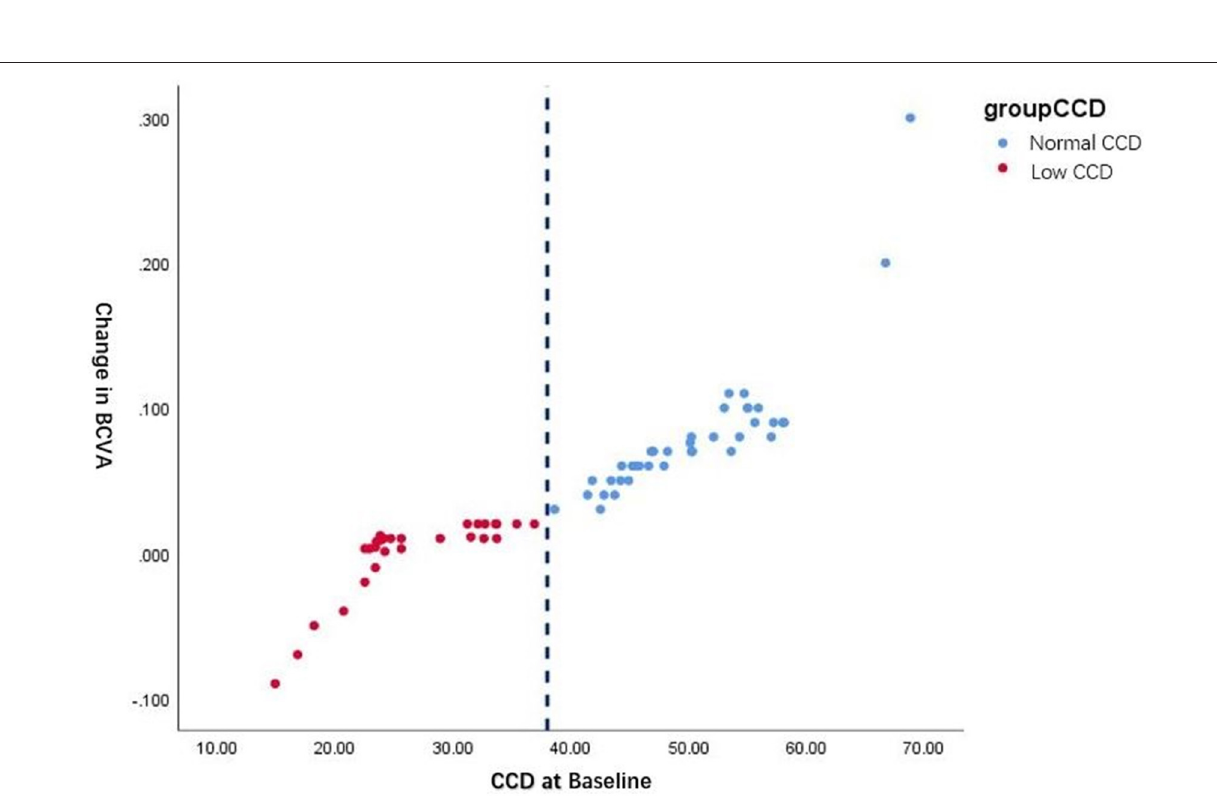
Frontiers in Medicine |